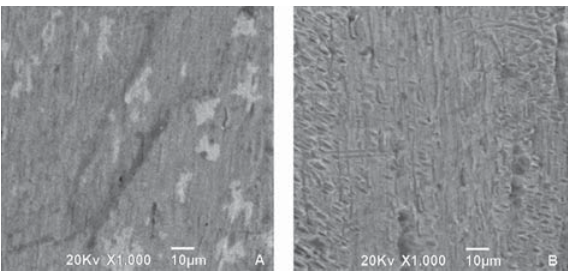
Figure 8- Scanning electron microscopy micrograph showing surface topography of CB slot (associated with SS wire) before (A) and after (B) mechanical